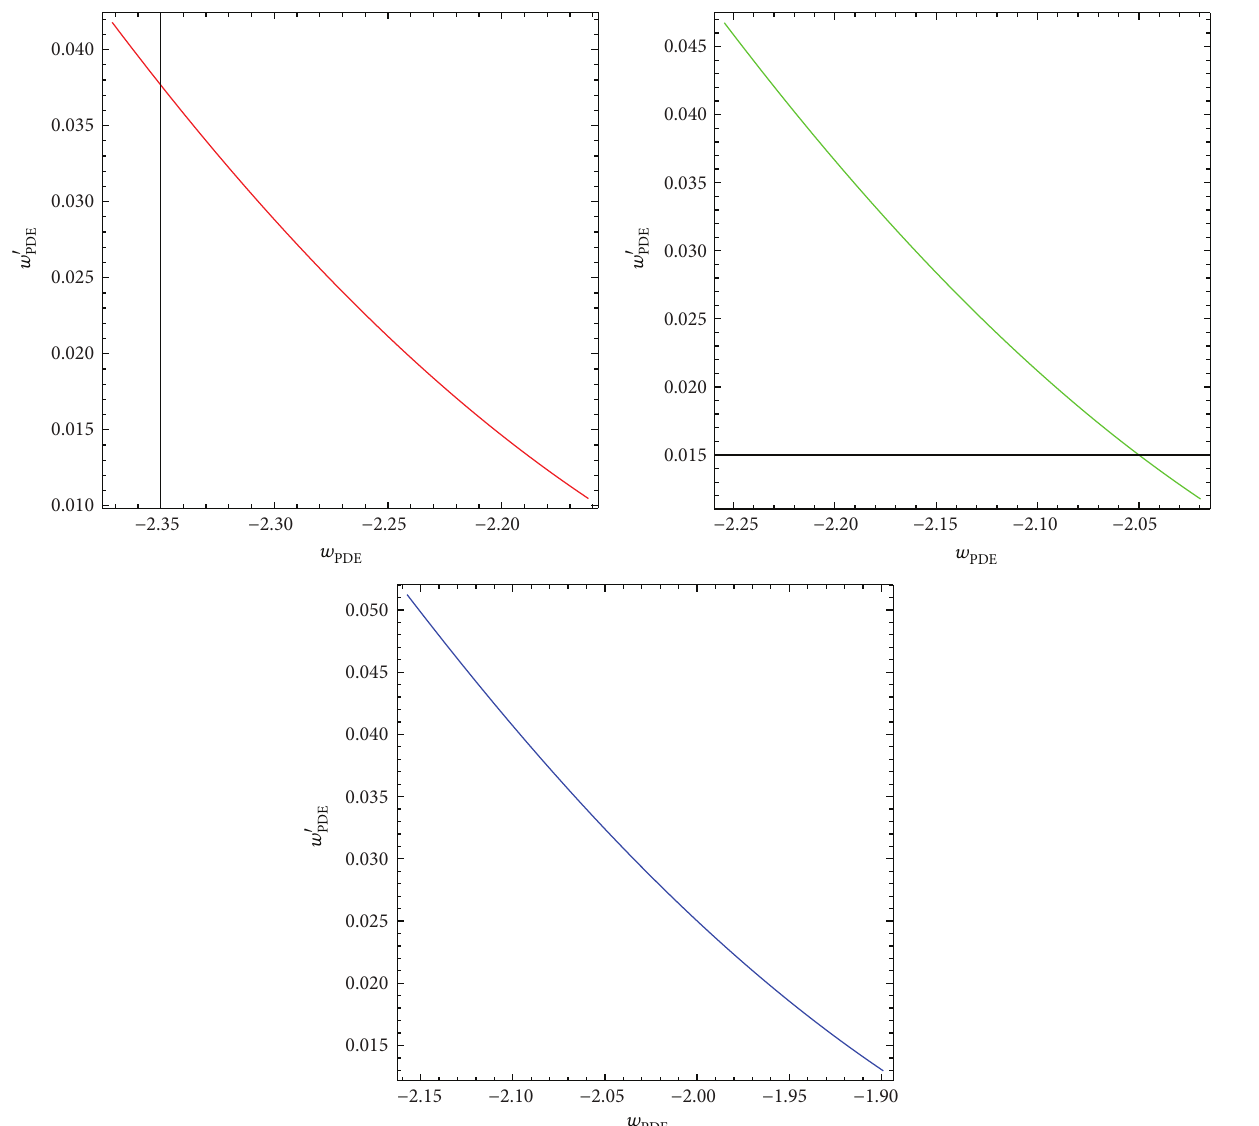
Figure 8: Trajectories of 𝑤 - 𝑤 󸀠 for reconstructed PDE 𝑓(𝐺) model for 𝑢 = −2 with 𝑚 = 2 (red), 𝑚 = 2.2 (green), and 𝑚 = 2.4 PDE PDE